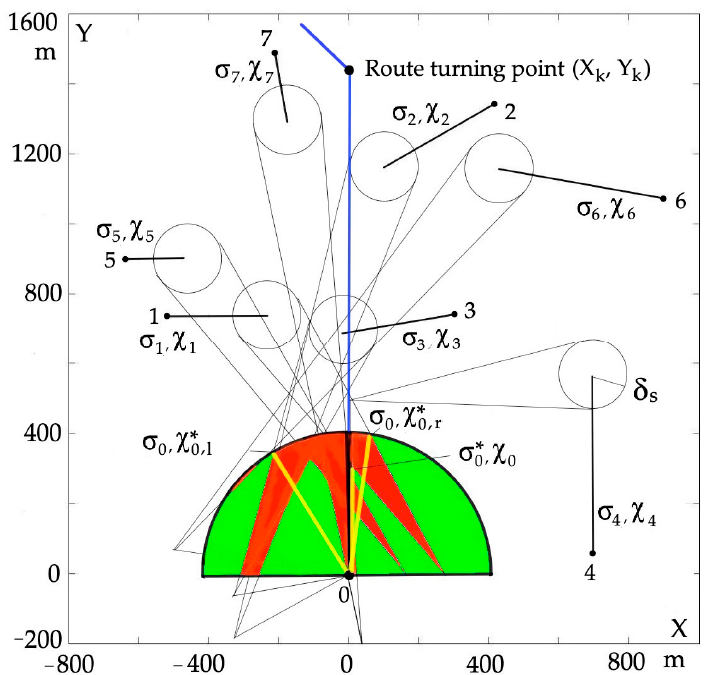
Figure 3. Graphic design of the area of acceptable maneuvers (green color) and prohibited maneuvers (red color) to move at a safe passing distance δ s in an autonomous vehicles’ group. A circle with a radius equal to the safe approach distance δ s is drawn around the position of each vehicle. Tangents to these circles, drawn from our autonomous vehicle, define in a semicircle with a radius equal to the speed of our autonomous vehicle; they define areas of dangerous approach at a distance less than δ s (red color) and the safe passing area at distances greater than δ s (green color).